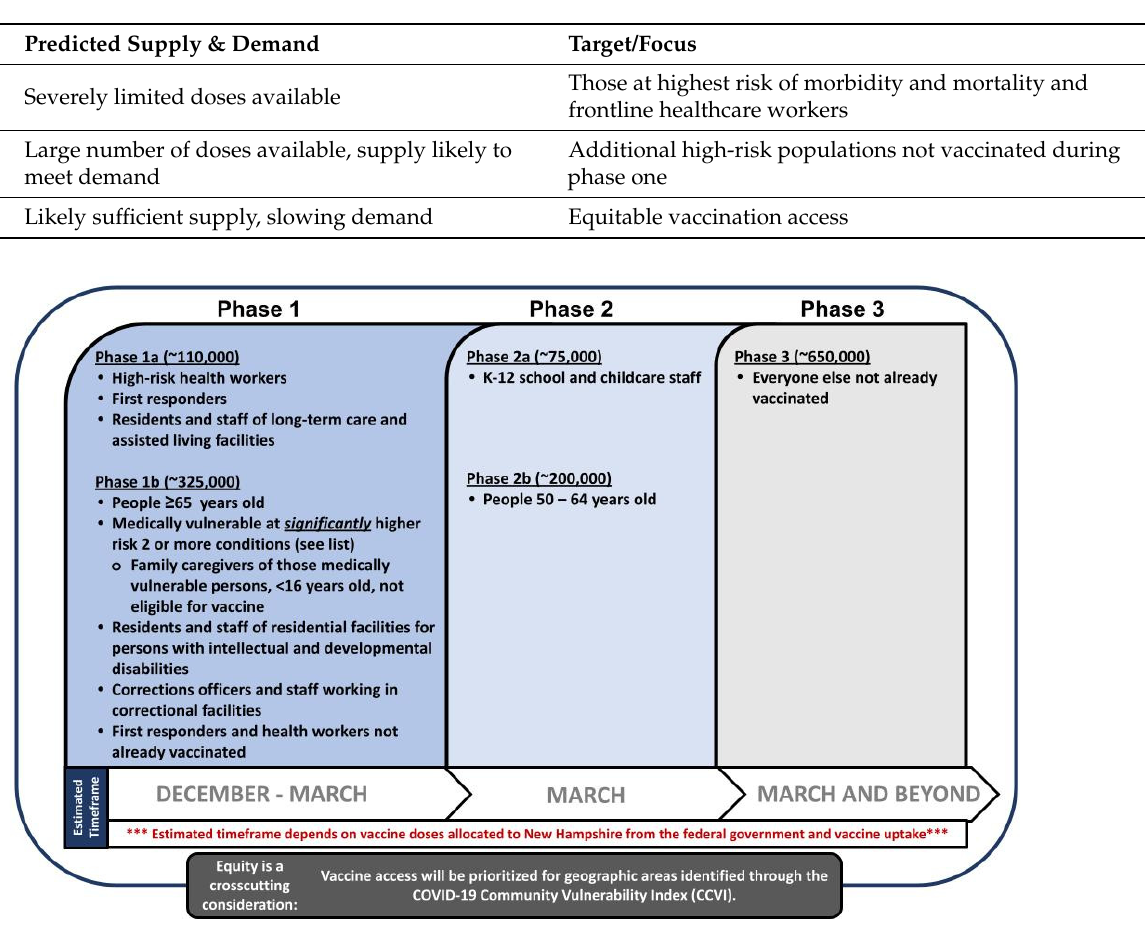
Table 2. Centers for Disease Control and Prevention (CDC) recommended three-phase allocation strategy, reflecting supply and demand of COVID-19 vaccine [5].